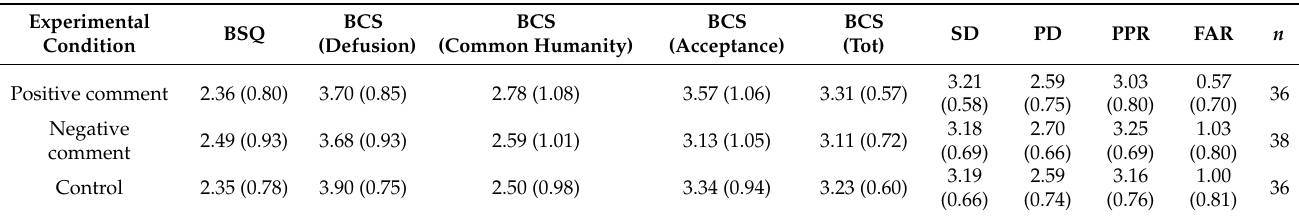
Table 1. Means ( SDs ) of women’s body dissatisfaction, body compassion, and quality of couple relationship by experimental condition.